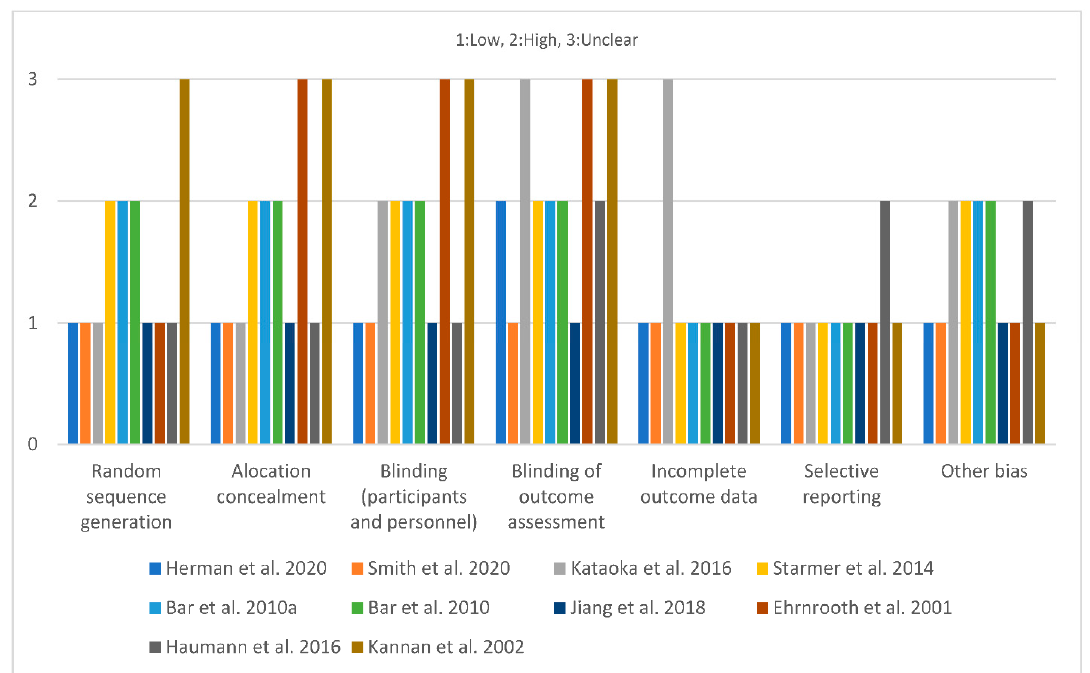
Figure 2. Quality Assessment of Included Studies. (Herman et al., 2020 [26]; Smith et al., 2020 [27]; Kataoka et al., 2016 [28]; Jiang et al., 2018 [29]; Haumann et al., 2016 [30]; Bar et al., 2010a [31]; Bar et al., 2010 [32]; Ehrnrooth et al., 2001 [33]; Starmer et al., 2014 [34]; Kannan et al., 2002 [35].